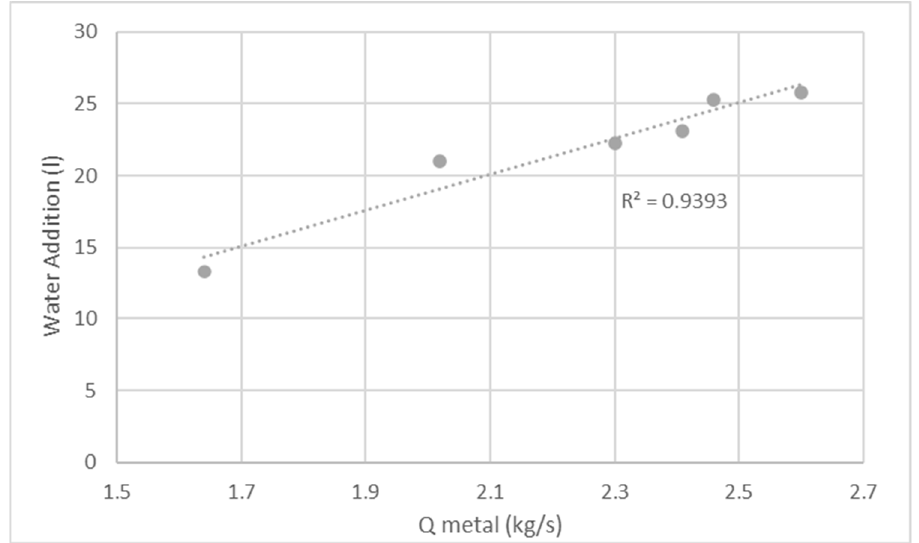
Figure 6. Relationship between metal flow with respect to the addition of water when the outlet temperature of the sand is 60 °C.